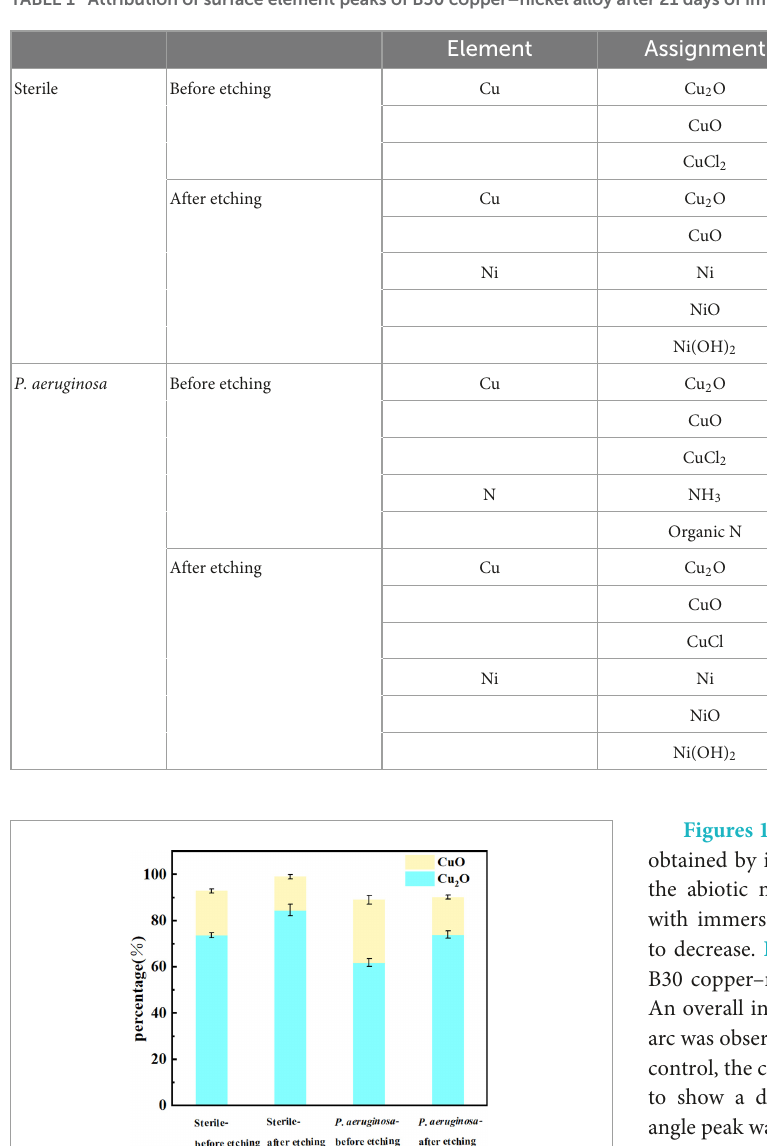
TABLE 1 Attribution of surface element peaks of B30 copper–nickel alloy after 21 days of immersion in P. aeruginosa .